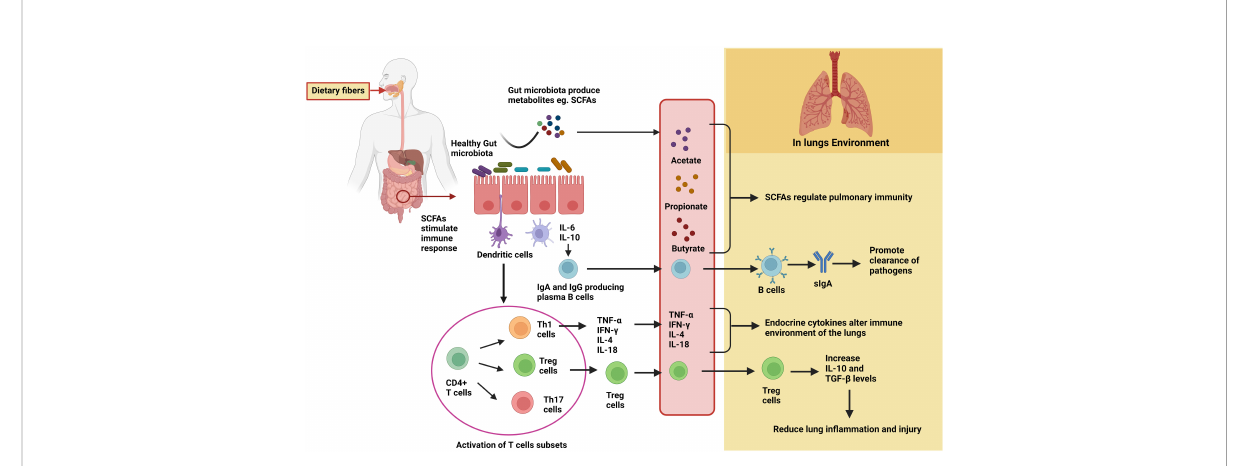
FIGURE 4 Detailed mechanisms of gut microbiota in modulating lung immunity through the gut – lung axis. Fermentation of dietary fi bers by the gut microbiota results in the production of metabolites, particularly SCFAs. SCFAs either directly migrate to lung tissues through the circulation and regulate pulmonary immunity or promote differentiation and activation of immune cells to produce cytokines and IgA. In the lungs, IgA promotes clearance of pathogens, Treg cells reduce lung in fl ammation and injury, and certain cytokines (such as TNF- a , IL-4, etc.) alter the immune